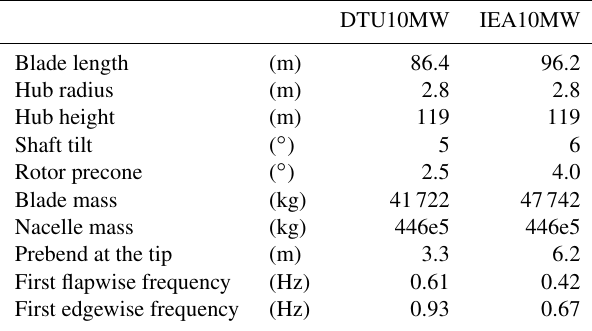
Table 2. HAWC2 turbine models’ main bodies and number of ele- ments and sub-bodies used in each main body.